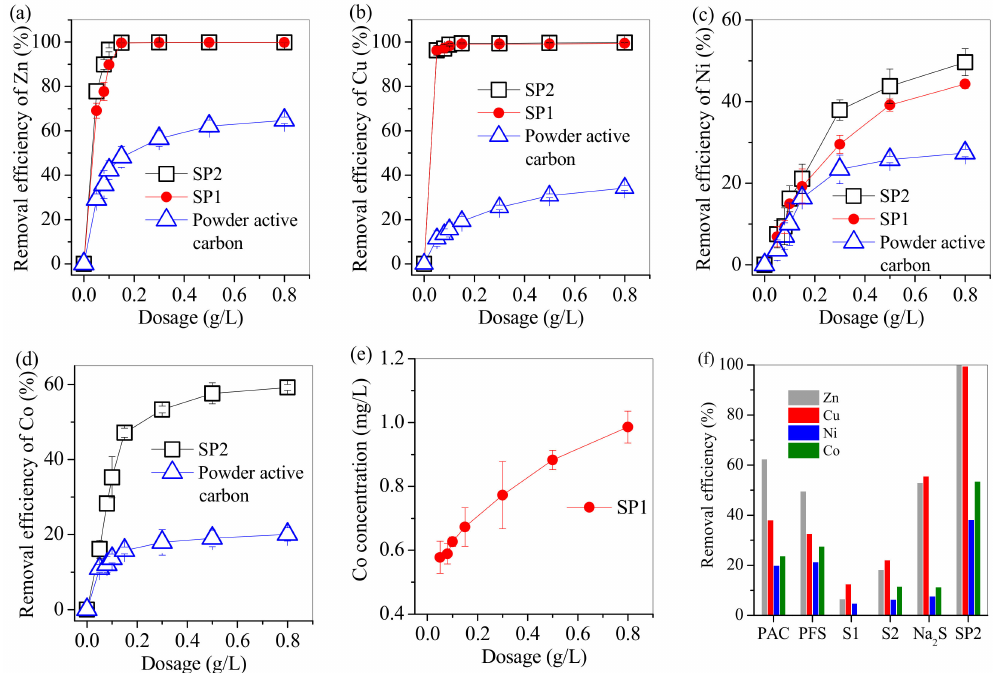
Figure6. ApplicationofSP1andSP2inelectroplatingwastewatertreatment. ( a – d )representtheremoval e ffi ciencies of Zn, Cu, Ni and Co, respectively, by SP1 and SP2, whilst ( e ) shows the concentration of Co in the supernatant with the addition of SP1; ( f ) shows the removal of heavy metals by adding SP2 in comparison with polyaluminum chloride (PAC), polyferric sulfate (PFS), the raw sludge S1 and S2 and Na 2 S · 9H 2 O of chemically pure grade.